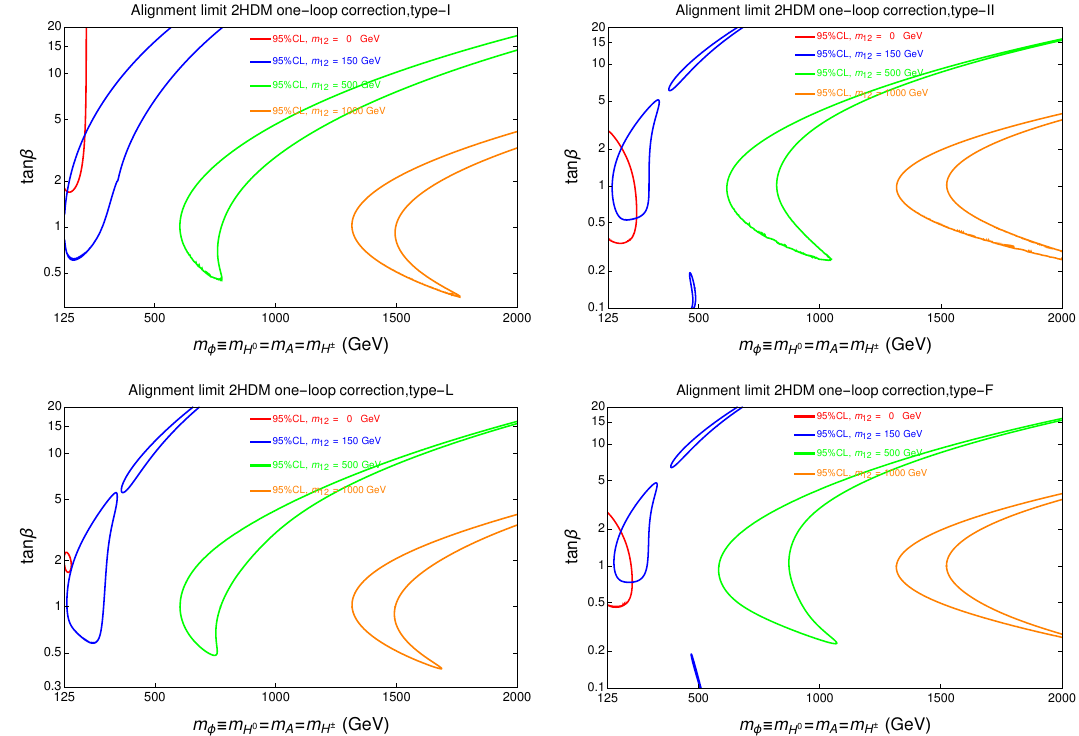
Figure 9 . The same global (cid:12)tting results with CEPC as (cid:12)gure 6, with di(cid:11)erent values of m 2 instead of (cid:21)v 2 . The survival regions exhibit (almost) enclosed behavior, with both upper and lower limit on m (cid:30) for a given value of tan (cid:12) .